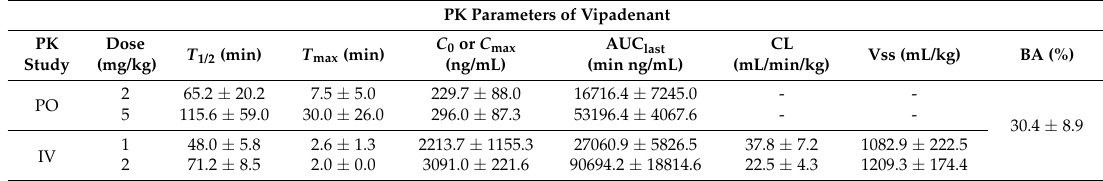
Figure 3. Time-concentration profiles of vipadenant from ( a ) IV (intravenous) 1, 2 mg/kg study and ( b ) PO (oral) 2, 5 mg/kg study. Table 5. Pharmacokinetic parameters of vipadenant from IV/PO PK study. PK Parameters of Vipadenant